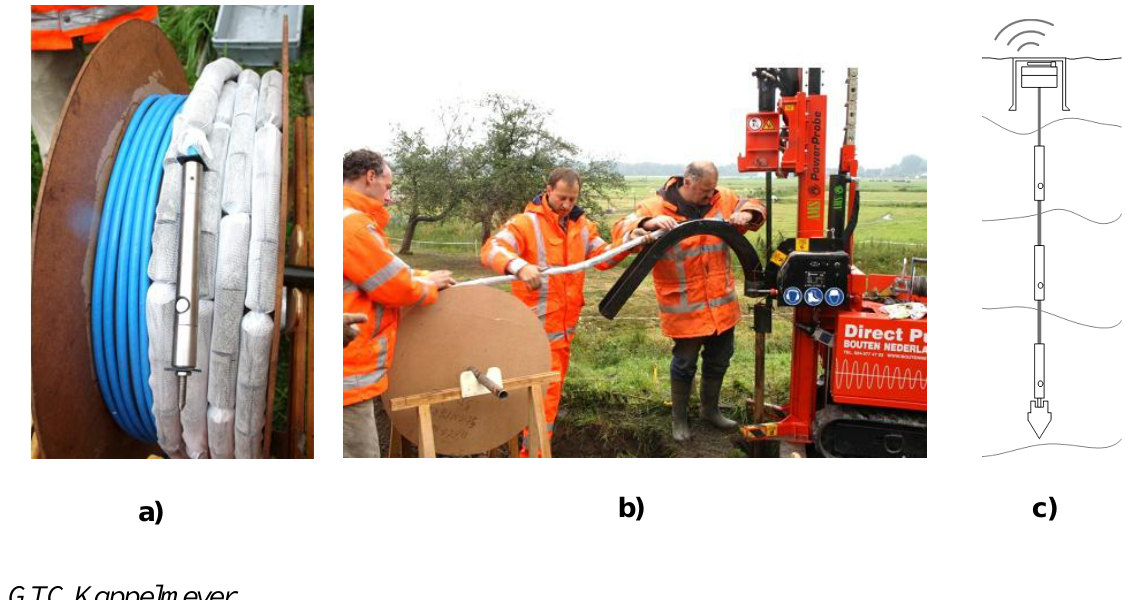
Figure 9. ( a ) GeoBeads sensor string with integrated bentonite shells for hydraulic isolation between measurement depths. ( b ) Installation of a GeoBeads string using a light weight direct push-in rig with sonic drilling head. ( c ) Schematic overview of a GeoBeads sensor string installed vertically for multilevel measurements as applied in levees, mountain slopes and construction activities.